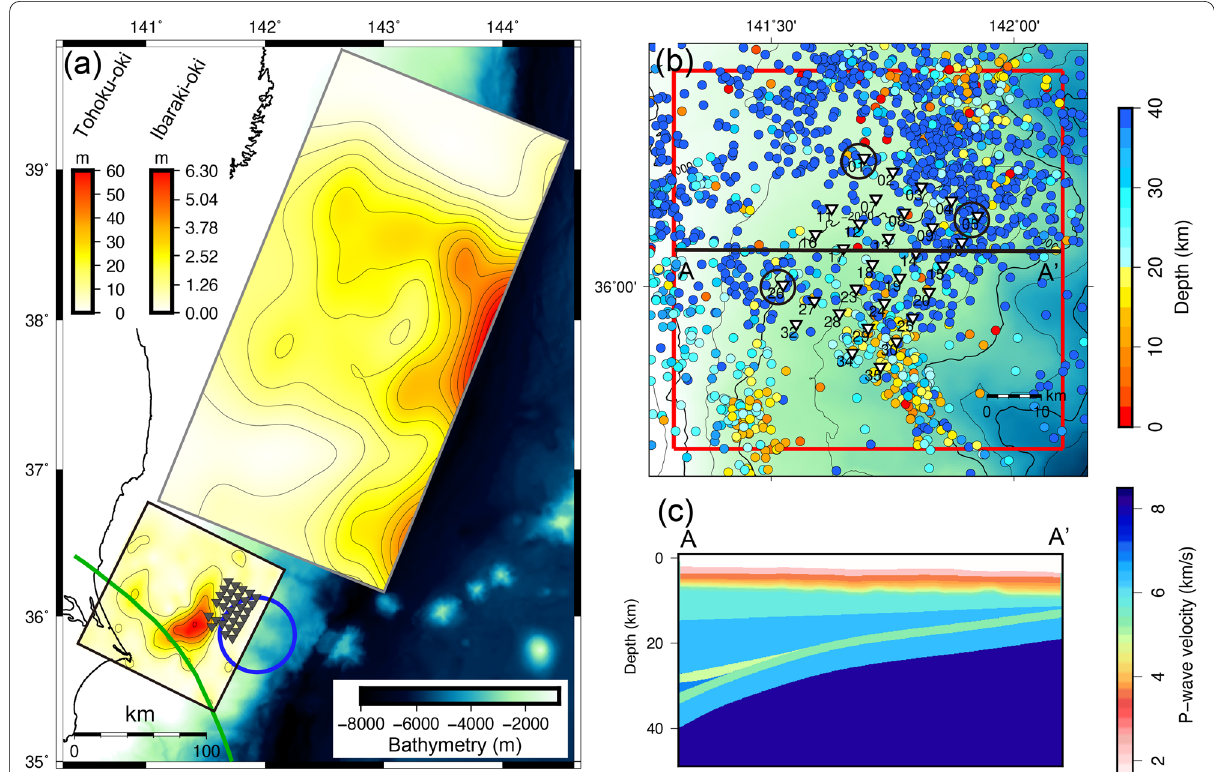
Fig. 1 a Study area with the slip distribution of the 2011 Tohoku-oki earthquake within a grey square (Lay et al. 2011), as well as the 2011 Ibaraki-oki earthquake within a black square (Kubo et al. 2013). The grey triangles show the stations of the OBS array in the off Ibaraki region. The blue circle shows the subducting seamount (Mochizuki et al. 2008). The green line shows the northeastern limit of the Philippine Sea Plate (Uchida et al. 2010). b Distribution of seismicity and OBS stations. The white triangles show OBS stations. The circled white triangles show the stations which were recovered approximately 2 weeks after the 2011 Tohoku-oki earthquake occurred. The colored circles show the earthquake hypocenters determined by JMA with their color indicating their depth. The red rectangle represents the region, where the Green’s functions were calculated. c Seismic velocity structure model along profile A–A’ in ( b ). The region shallower than ~ 10 km was constructed by Yamaya et al. (2021), and deeper by Koketsu et al.